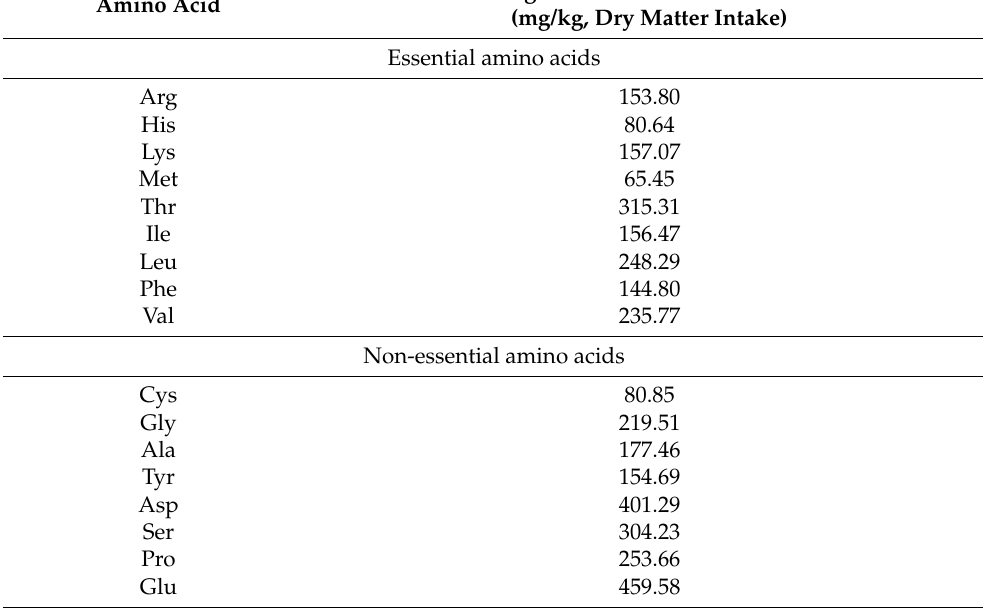
Table 5. Concentration of the ileal endogenous amino acid losses of the broilers fed a nitrogen- free